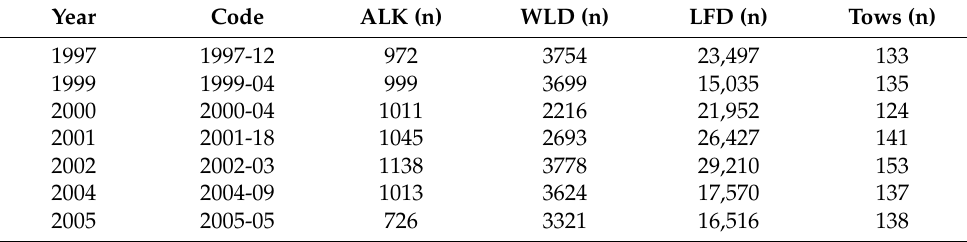
Table 1. Year, survey code, and number of specimens and fishing tows utilized to build the